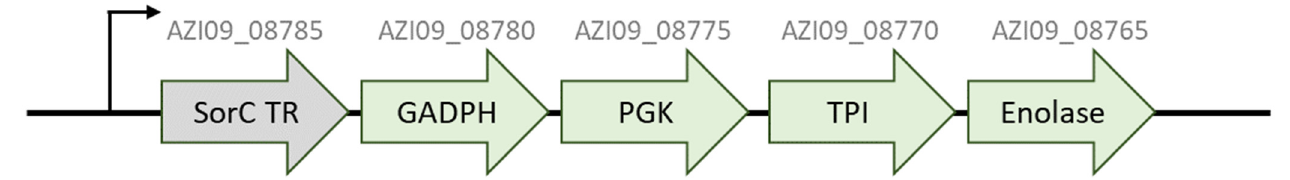
Figure 9. Operon of putative moonlighting proteins. GADPH (glyceraldehyde-3-phosphate dehy- drogenase), PGK (phophoglycerate kinase), TPI (triose-phosphat isomerase), and enolase. genase), PGK (phophoglycerate kinase), TPI (triose-phosphat isomerase), and